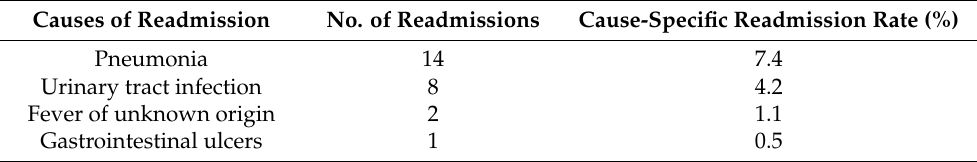
Table A3. Readmissions and cause-specific readmission rate after implementing LACE score-based predictive risk management tool to a home care patient cohort of a medical center affiliated home care unit in Taiwan in 2019. ( n = 190,